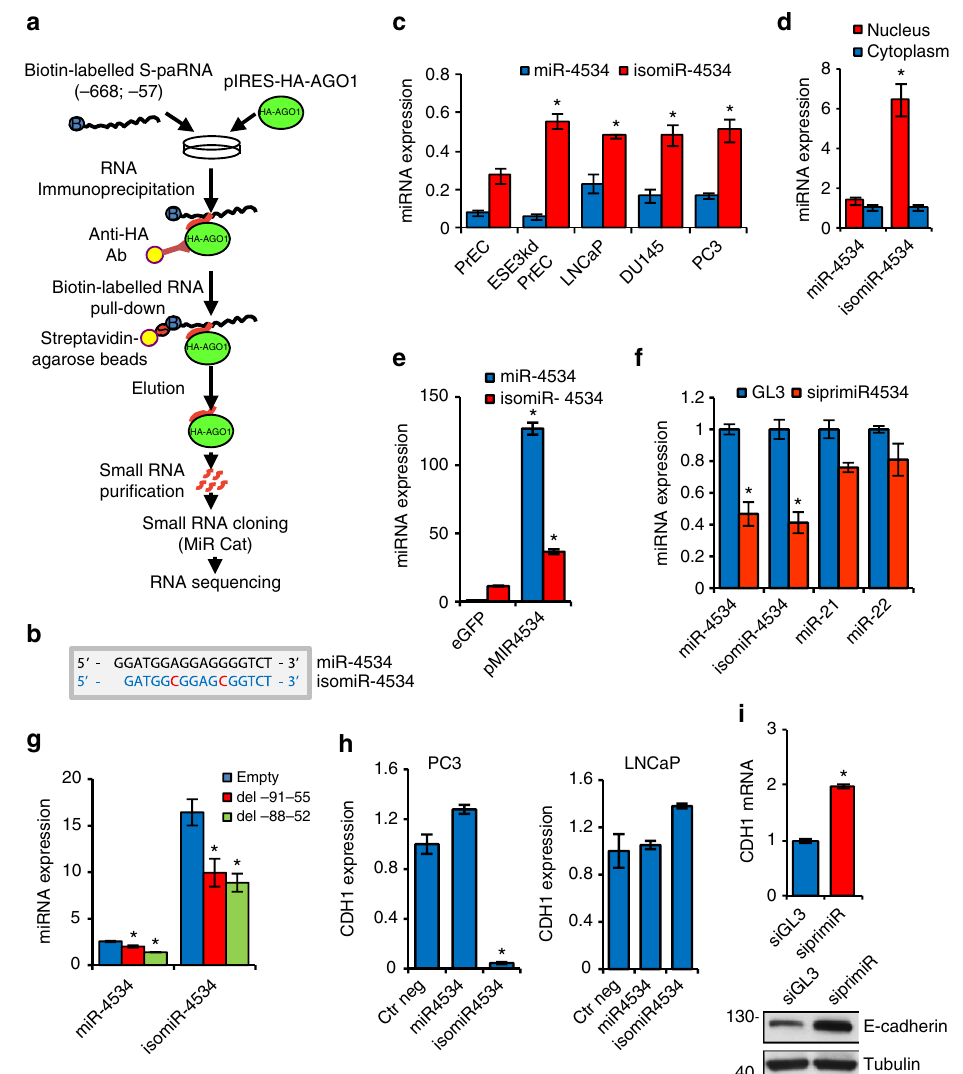
Figure 4 | IsomiR-4534 binds to Argonaute 1 and controls CDH1 expression. ( a ) Protocol for miRNA identification by RIP, biotin-labelled RNA pull-down and small RNA sequencing. ( b ) Sequence of miR-4534 and isomiR-4534. Red, nucleotide changed in isomiR-4534. ( c ) miR-4534 and isomiR-4534 expression in prostate normal (PrECs), tumorigenic (ESE3kd-PrECs) and cancer cell lines (LNCaP, DU145 and PC3). ( d ) Nuclear and cytoplasmic distribution of miR-4534 and isomiR-4534 in PC3 cells. ( e ) miR-4534 and isomiR-4534 expression in DU145 cells 24h after transfection with pre-miR-4534 (pMIR4534) or control expression vector. ( f ) Expression of miR-4534, isomiR-4534, miR-21 and miR-22 in PC3 cells after transfection of pri-miR-4534 targeting (siprimiR) or control (siGL3) siRNA. ( g ) miR-4534 and isomiR-4534 expression in DU145 cells transfected with pre-miR-4534 targeting gRNA constructs (del91-55 and del88-52) or empty vector and selected with puromycin. ( h ) CDH1 expression in PC3 (left) and LNCaP (right) cells after transfection with miR4534 and isomiR-4534 mimics or negative control (ctrl neg) miRNA. ( i ) CDH1 mRNA (top) and protein (bottom) expression in DU145 cells transfected with pri-miR-4534 targeting siRNA (siprimiR) or siGL3. Data are mean ± s.d. of three independent determinations. Student’s t -test was used for P value assessment. * P o 0.05.